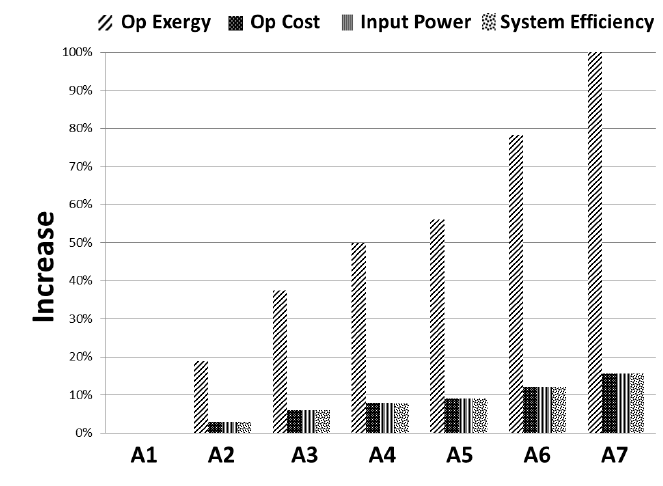
Figure 11. Comparison before and after PLDA